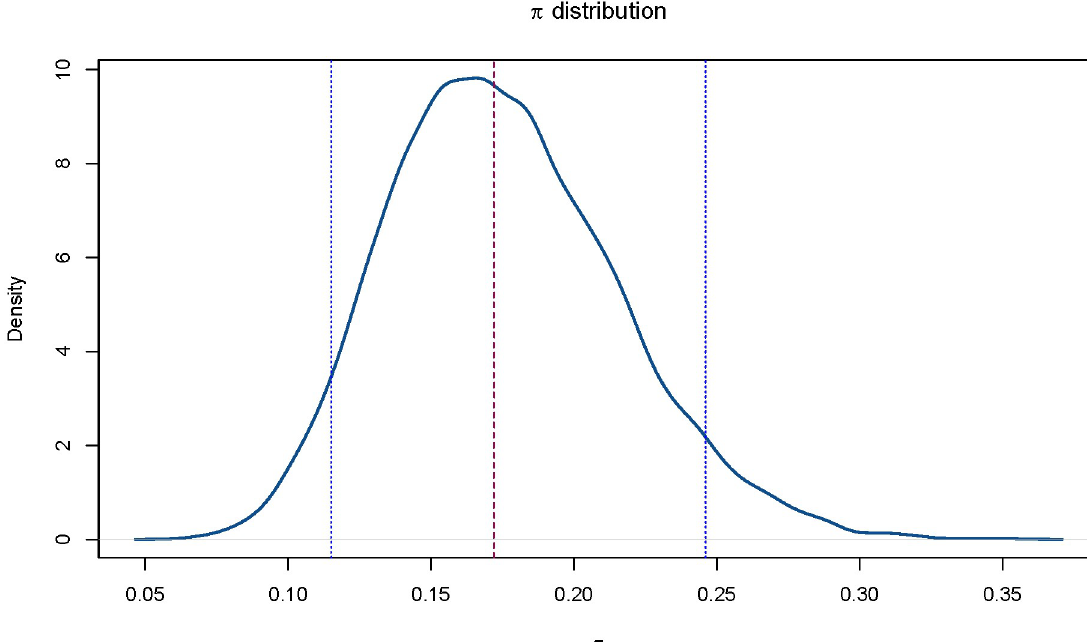
Fig 2. Monte Carlo approximation of the distribution of the probability π with median (dashed red line), 5th and 95th percentiles (dashed blue lines).